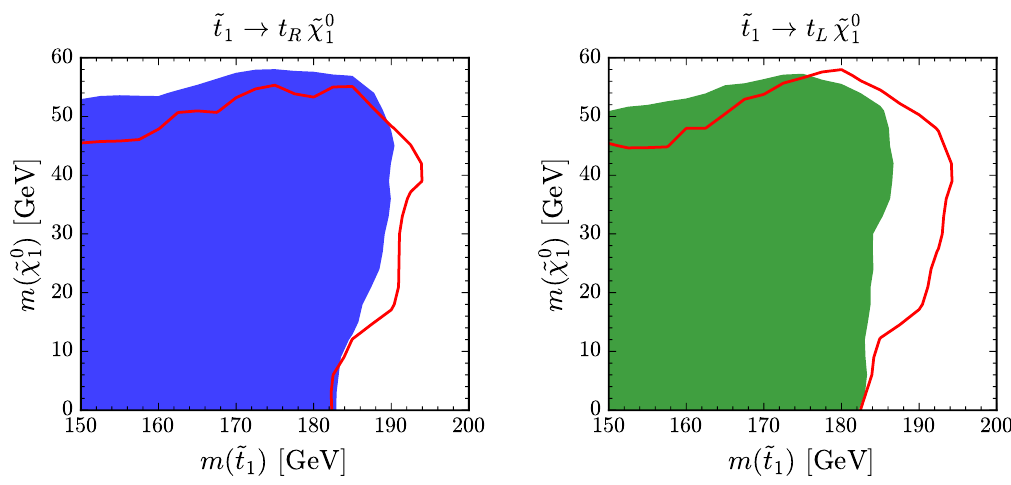
Figure 11 . The shaded regions are excluded by our reinterpretation of the ATLAS t (cid:22) t cross section measurement at the 95% CL in the MG Full approximation. The left (right) panel shows when the stop decays through a right- (left-) handed top. The red line shows what exclusion we would derive if spin correlations were not taken into account, i.e. in the P NWA